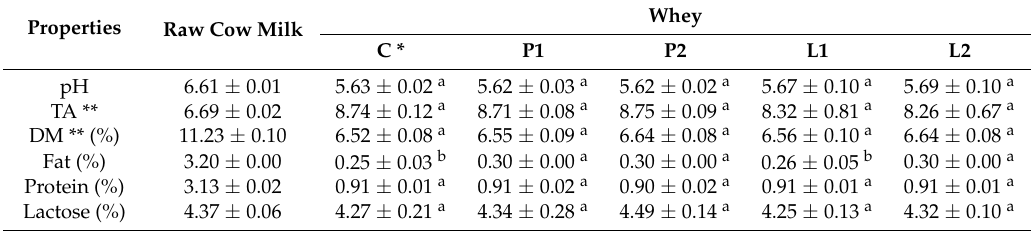
Table 1. Composition of the raw cow milk and whey of White cheeses ( n =